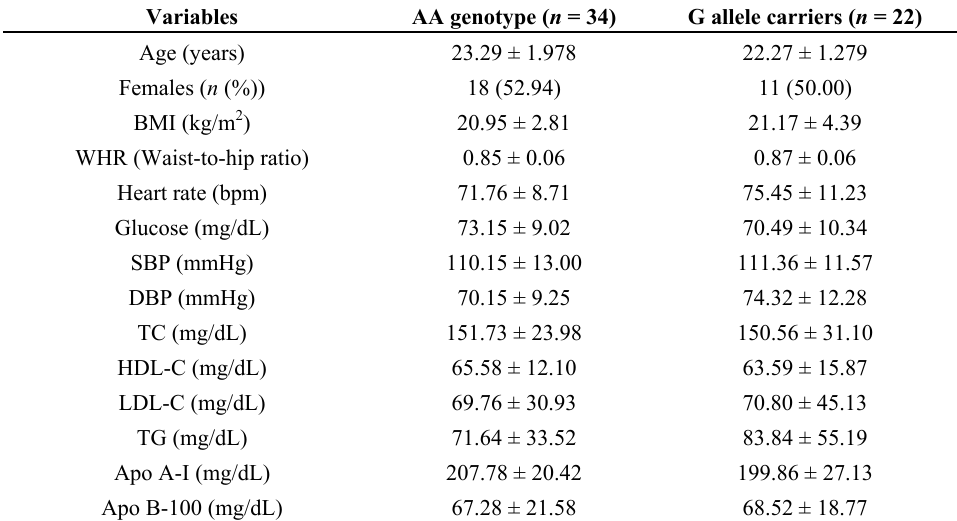
Table 3. Anthropometric and biochemical characteristics of the